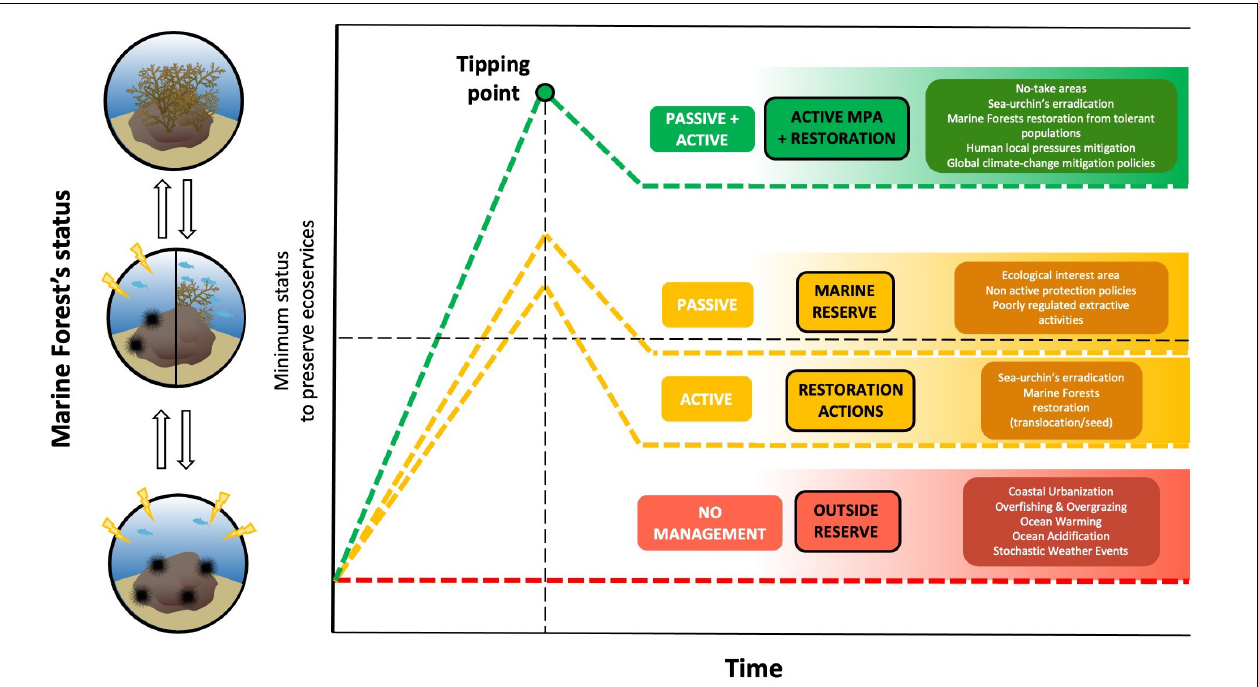
FIGURE 4 | Different theoretical scenarios of restoration efforts: ( • ) MPA: no-take areas and restoration actions (passive + active, e.g., sea-urchin’s eradication, revegetation, human local pressures mitigation, and climate-change mitigation policies), ( • ) marine reserve (passive: non-active protection), ( • ) restoration actions (active), and ( • ) outside reserve (no management) with the hypothetical tipping point to overcome. For those highly degraded communities, only a combined management of active and passive activities is suggested as the option able to have a long-term recovery scenario. MPA, marine protected area. Symbols courtesy of the Integration and Application Network, University of Maryland Center for Environmental Science